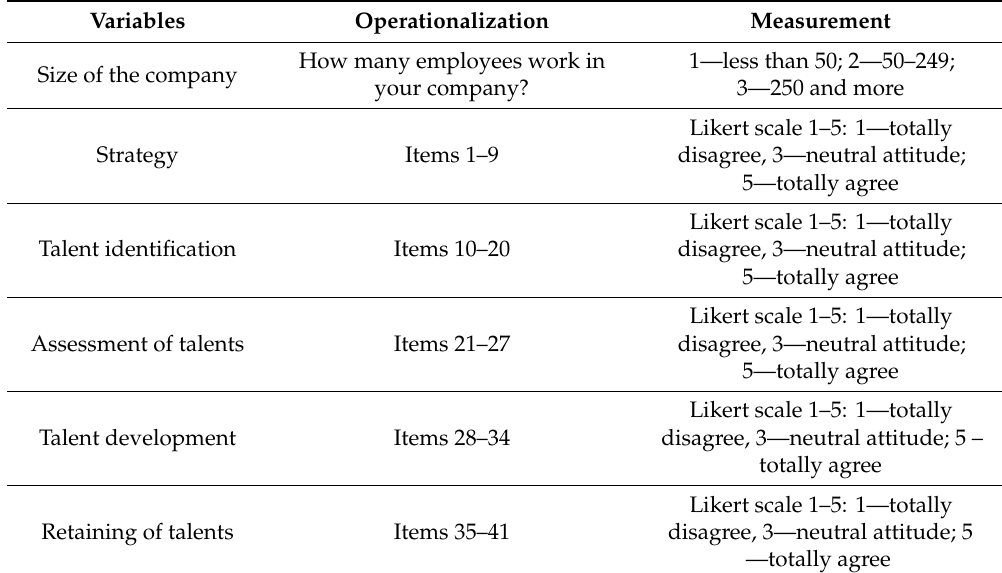
Table 2. Variables operationalization in the